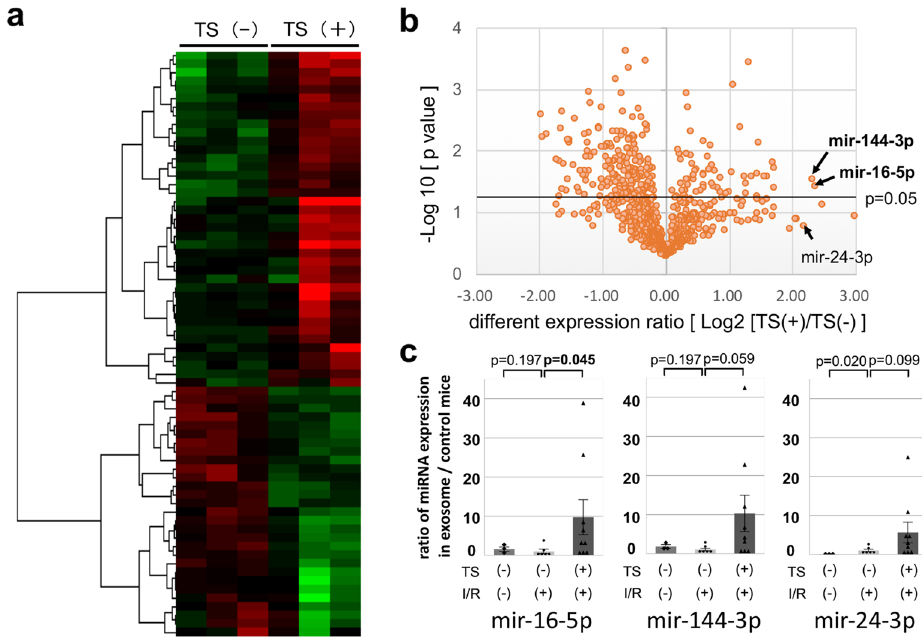
Figure 3. Specific exosomal-micro-RNAs in sarcopenic mice after I/R. ( a ) Comprehensive cluster analysis of miRNAs expression in the exosomes from I/R mice (both groups) showing the 68 differentially expressed miRNAs (fold change > 2.0). Green; down regulated miRNAs. Red; upregulated miRNAs. Left 3 lines; TS (−) mice. Right 3 lines; TS (+) mice. ( b ) Volcano plot analysis of 944 miRNAs. The horizontal lines show the p-values with respect to the differential expression analysis in the two groups. Two candidate miRNAs (upregulated) with a high differential expression ratio were plotted over the horizontal line. ( c ) Quantitative (q) RT-PCR analysis of the expression of miR-16-5p, miR-144-3p, and miR-24-3p in the two groups of I/R mice [I/R (+) TS (+); n = 9, I/R (+) TS (−); n = 6, I/R (−) TS (−); n = 3]. Left bar; I/R (−) TS (−). Center bar; I/R (+) TS (−). Right bar; I/R (+) TS